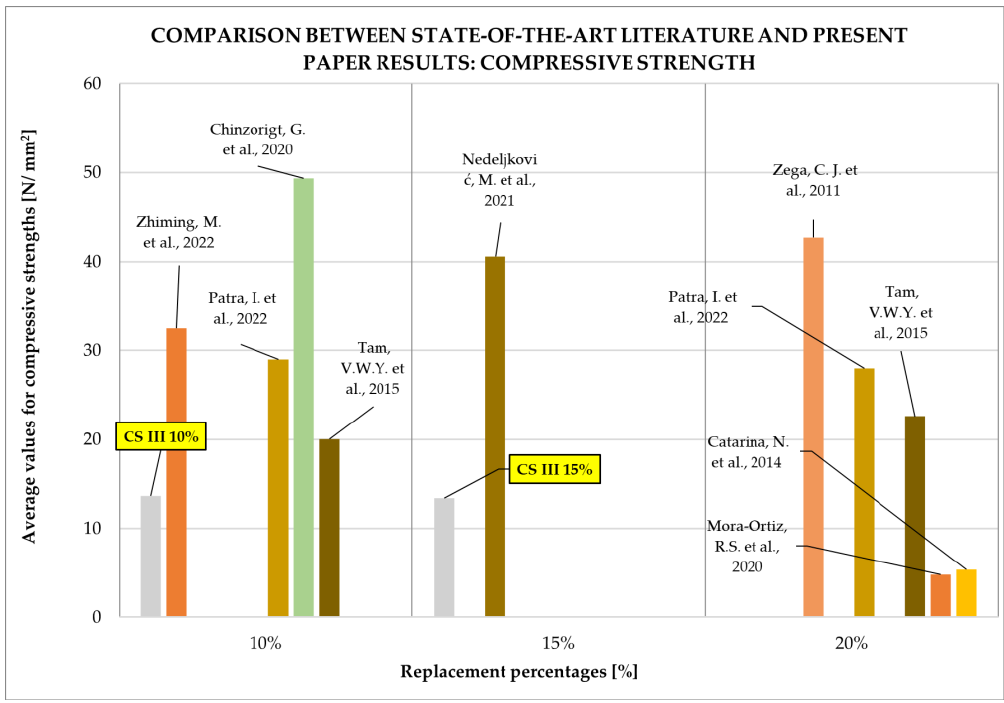
Figure 18. State-of-the-art and present research results for compressive strength [3,4,9 – 11,15,16,27]. Mora-Ortiz et al. [15], Zhiming et al. [16], Wu et al. [20], and Catarina et al. [27] pub-